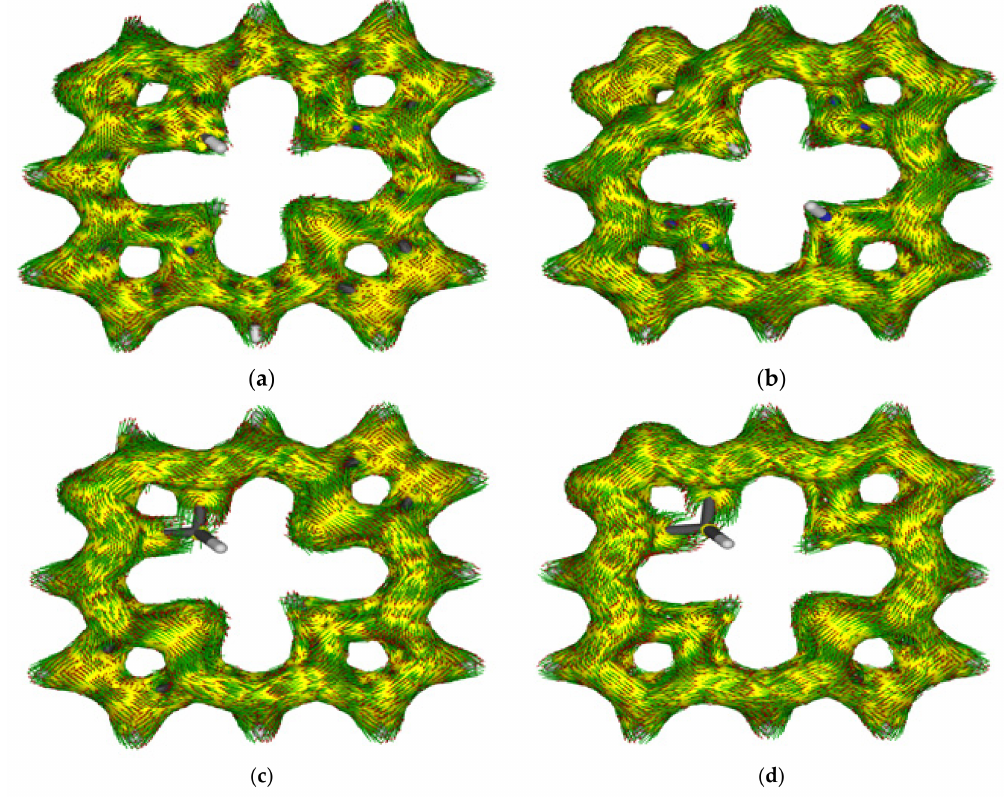
Figure 6. AICD plots (isovalues 0.05) for PzP-2,22,24-H + ( a ), PzP-22,23,24-H + ( b ), PzP-2,21,23-H + ( c ), and PzP-21,22,24-H + ( d